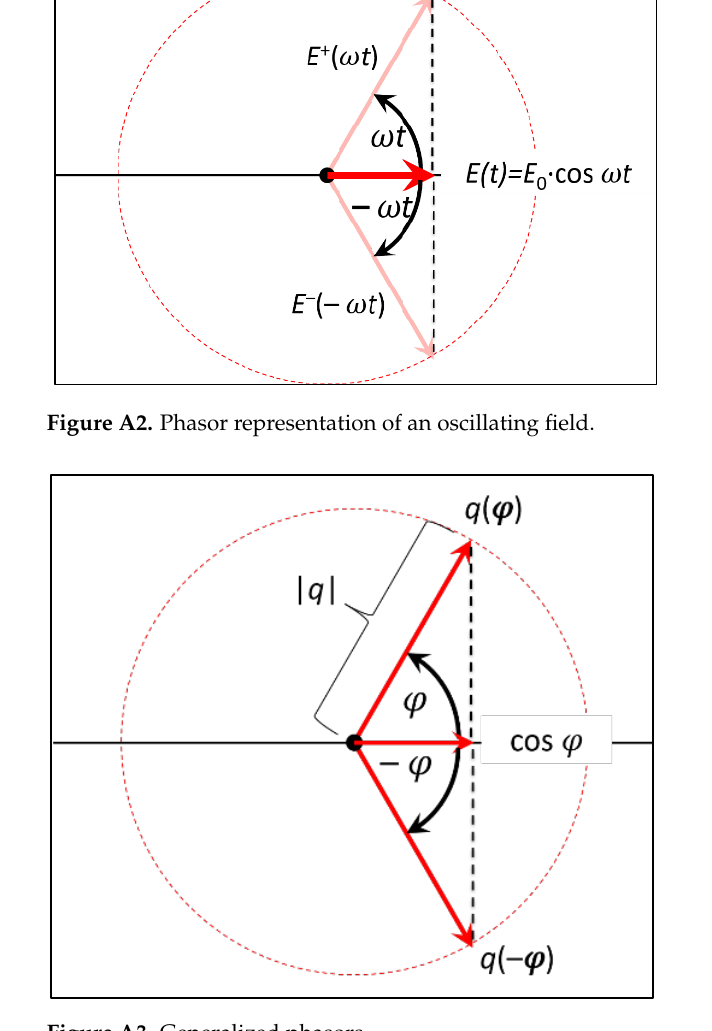
Figure A3. Generalized phasors. Table A1. Calculation rules for the phasors q ( φ